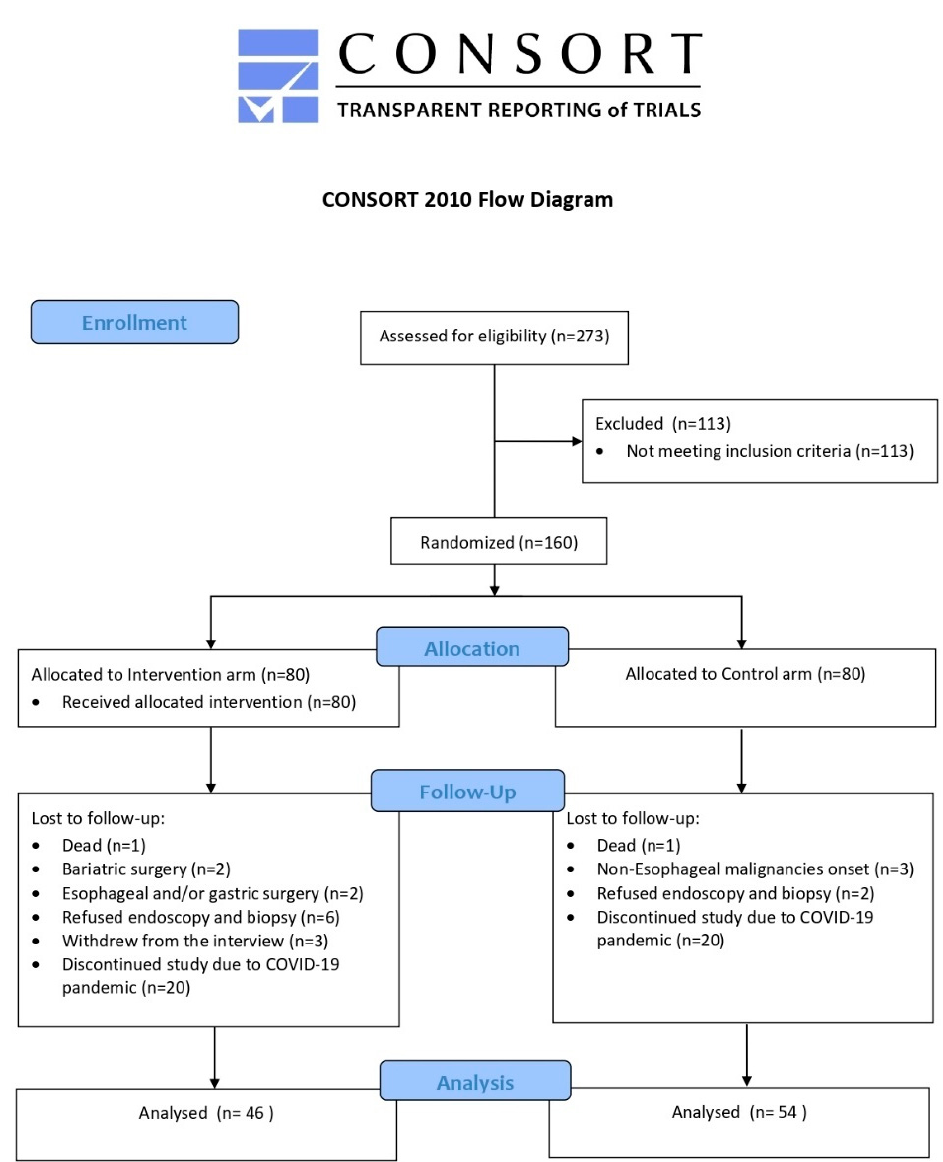
Figure 1. The trial’s CONSORT flow diagram.